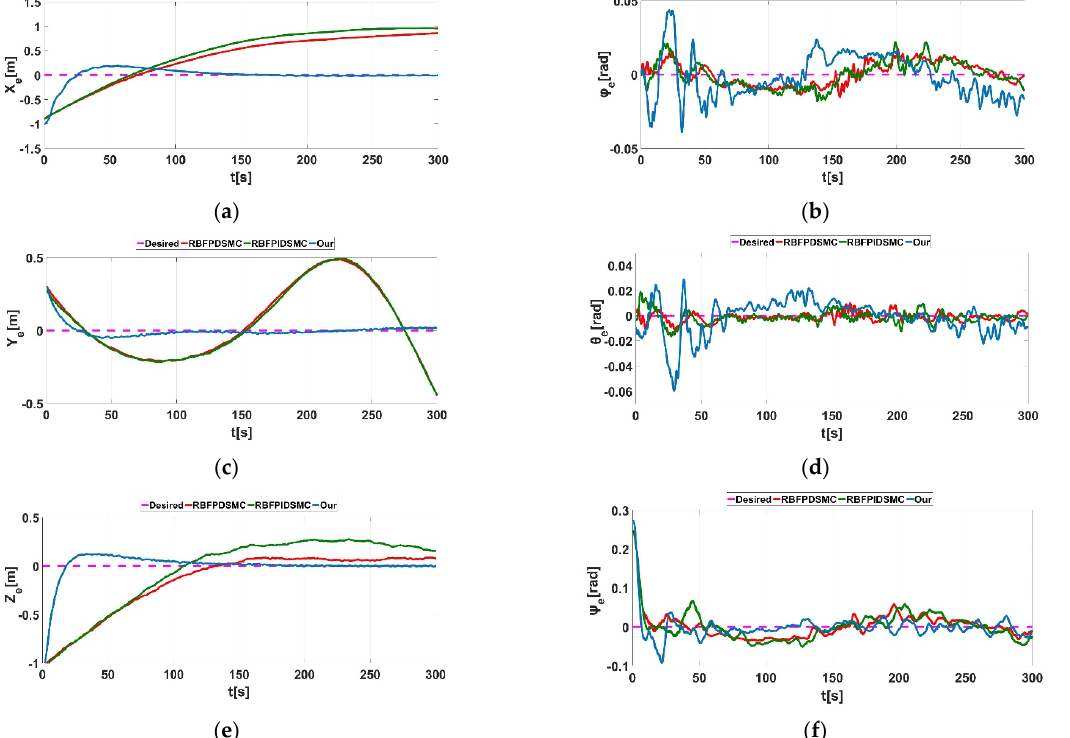
Figure 12. AUV position − tracking errors. ( a ) 𝑥 𝑒 ; ( b ) 𝜑